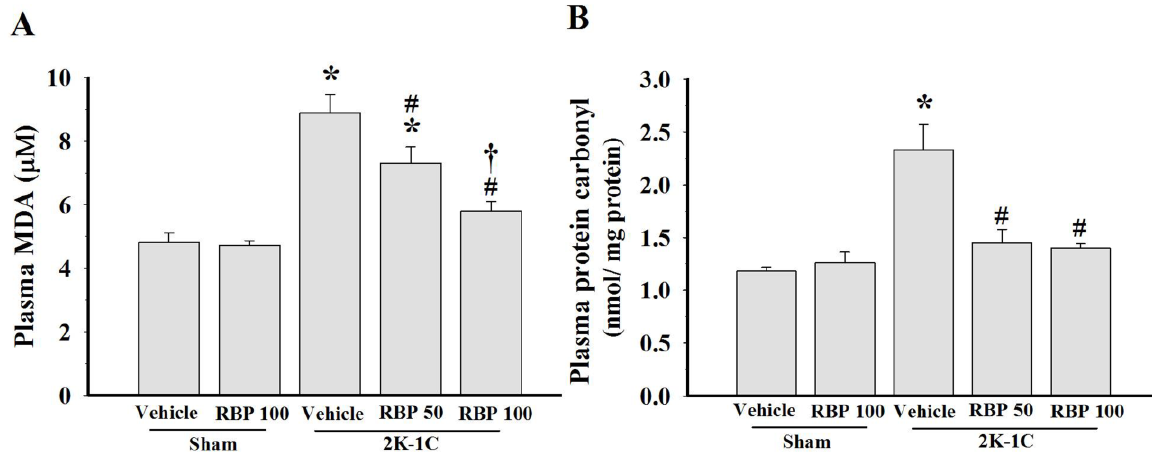
Figure 6. Effect of RBP on plasma malondialdehyde ( A ) and plasma protein carbonyls ( B ) concentrations. Data are mean values ± SEM; ( n = 8/group), * p < 0.05 vs. sham-operated group, # p < 0.05 vs. 2K-1C group and † p < 0.05 vs. 2K-1C + RBP50 group; Rice bran peptides, RBP.